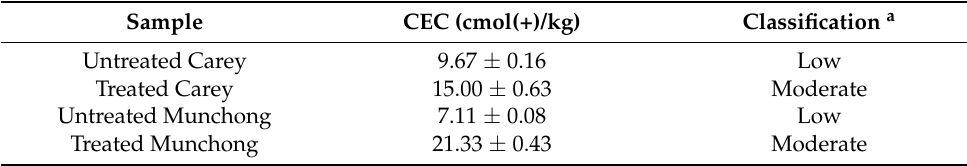
Table 4. Cation-exchange capacity of untreated and treated clay samples. Sample CEC (cmol(+)/kg) Classification a Untreated Carey 9.67 ± 0.16 Low Treated Carey 15.00 ± 0.63 Moderate Untreated Munchong 7.11 ± 0.08 Low Treated Munchong 21.33 ± 0.43 Moderate